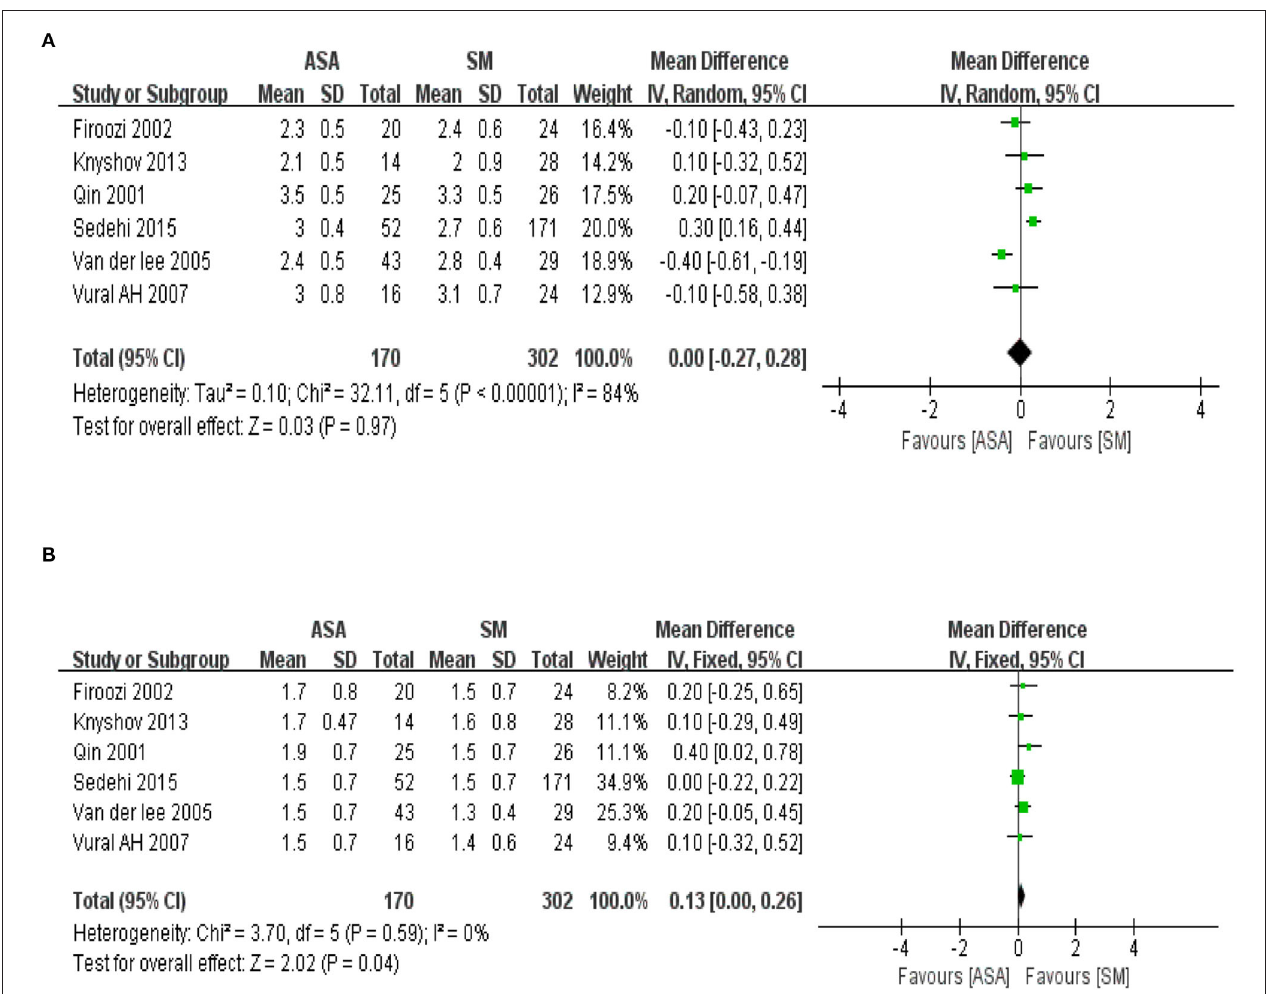
FIGURE 4 | (A) The forest map of baseline information in cardiac function of the included studies. IV, inverse variance; CI, confidence interval; Random, random effect mod. (B) The forest map of improvement on cardiac function after the procedures. IV, inverse variance; CI, confidence interval; Fixed, fixed effect